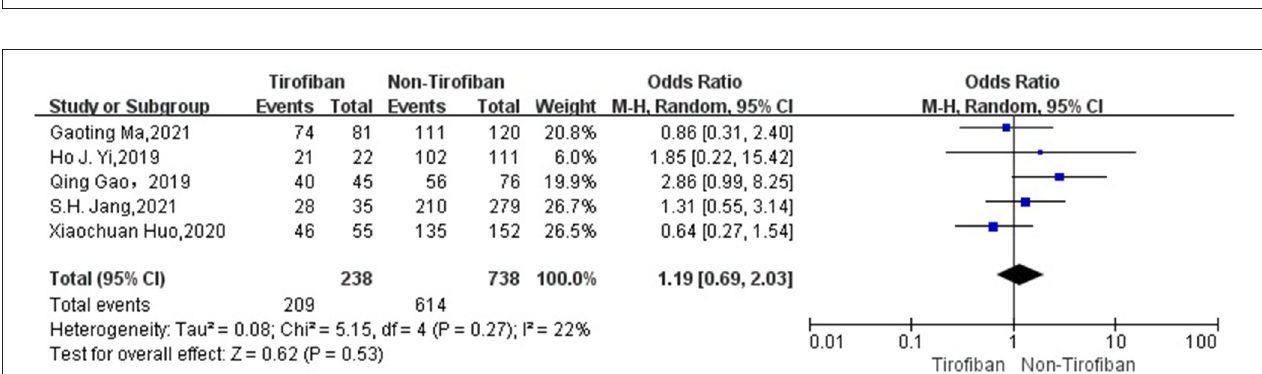
FIGURE 2 | Forest plot and meta-analysis of 3-month mRS 0–2 score. mRS, modified Rankin Scale.